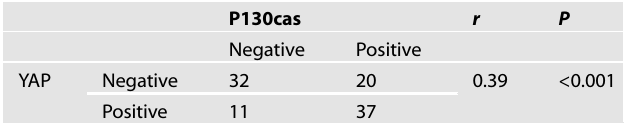
Table 3. Correlation of P130cas with the expression of YAP in 100 NSCLC